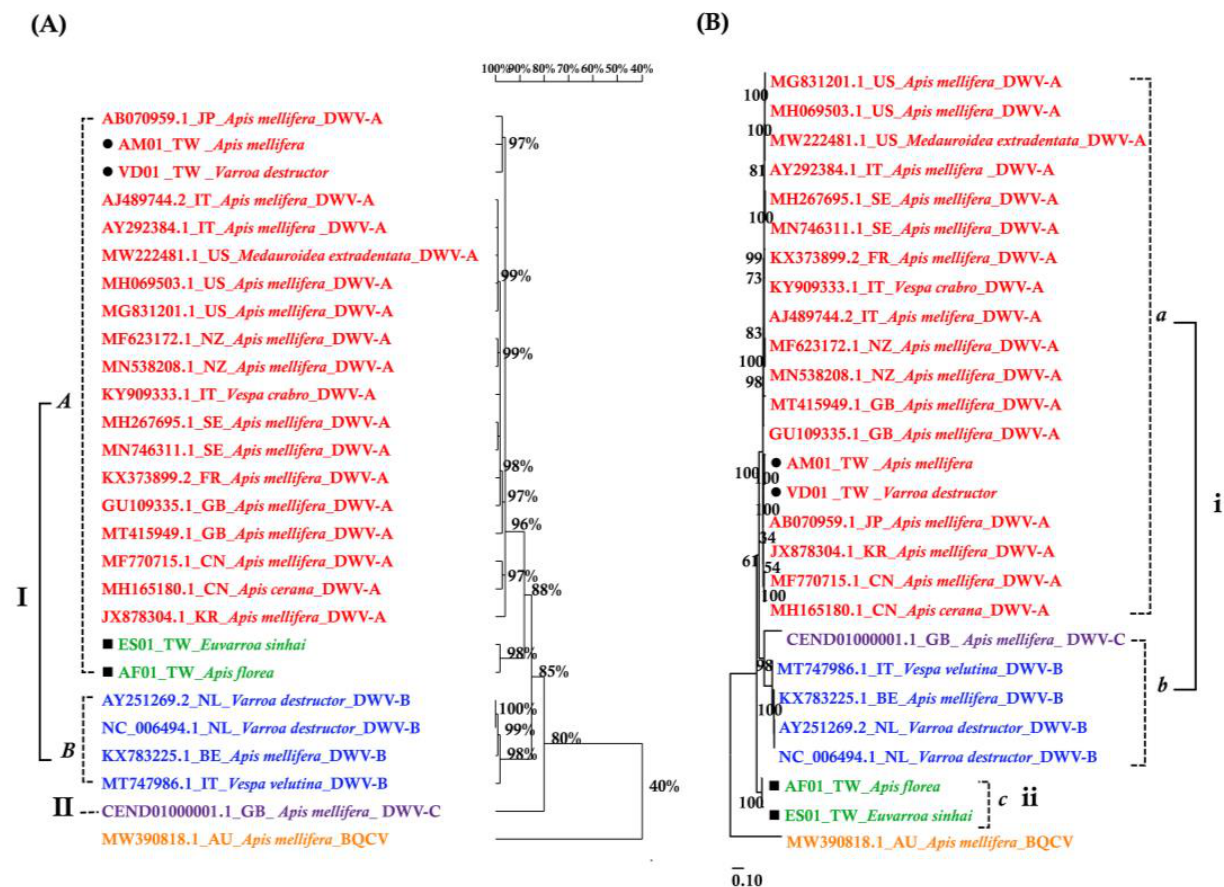
Figure 2. ( A ) Homology tree constructed based on the complete polyprotein sequence of four samples in this study; the 22 DWV-associated strains and Black queen cell virus complete genome (MW390818.1) were from the NCBI database. ( B ) Maximum-likelihood phylogenetic tree (Tamura-Nei model; 1000 replicates) inferred from complete polyprotein